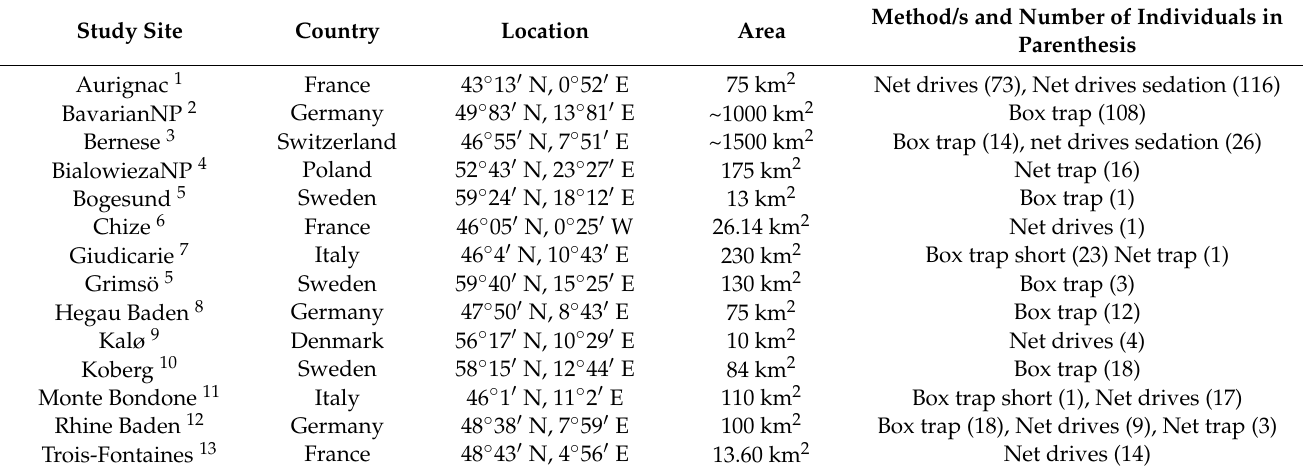
Table 1. Locations and methods of capture used across the study